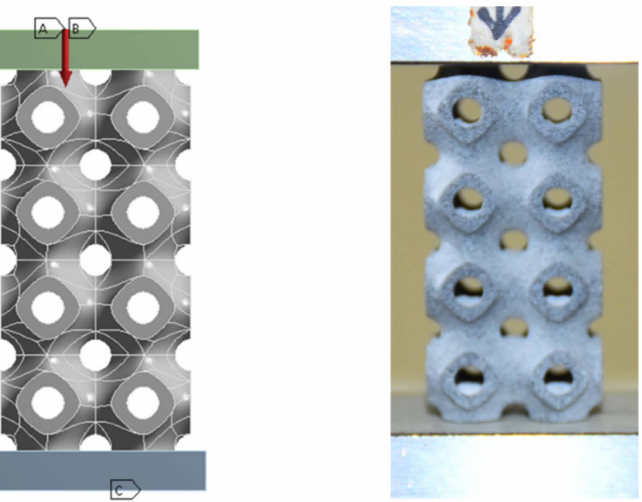
Figure 3. ( Left ): FEA setup showing load application and boundary conditions (A, B and C are load, remote displacement, and fix support respectively). ( Right ): Setup for uniaxial